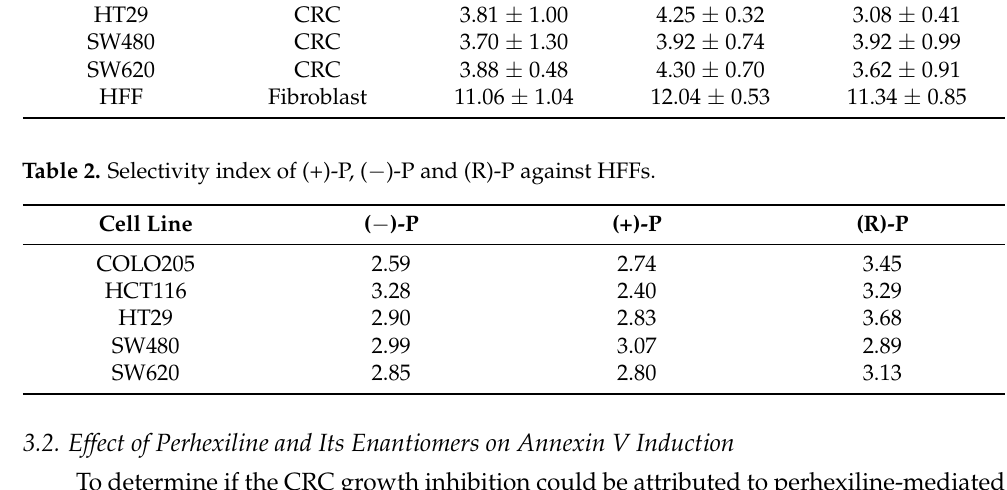
Figure 2. The effect of treatment with ( − )-P, (+)-P, or (R)-P on Annexin V staining in CRC cell lines. HT29 or SW620 cells were treated with different concentrations of -P, (+)-P and (R)-P for 48 h, then stained with Annexin V/PI and analysed by flow cytometry. ( a ) Representative flow cytometry scat- terplots, showing viable (Q4, double negative), early apoptotic (Q3, annexin V positive), late apop- totic (Q2, annexin V and PI positive) and necrotic (Q1, PI positive) HT29 cells. ( b ) The percentage of early apoptotic cells in HT29 cultures. ( c ) The percentage of early apoptotic cells in SW620 cultures. Results shown are mean ± SD of early apoptotic cells from technical replicates pooled from three independent experiments. * p ≤ 0.05, ** p ≤ 0.01,*** p ≤ 0.001, **** p ≤ 0.0001. One-way ANOVA with multiple comparisons test against vehicle (0 µM) control.